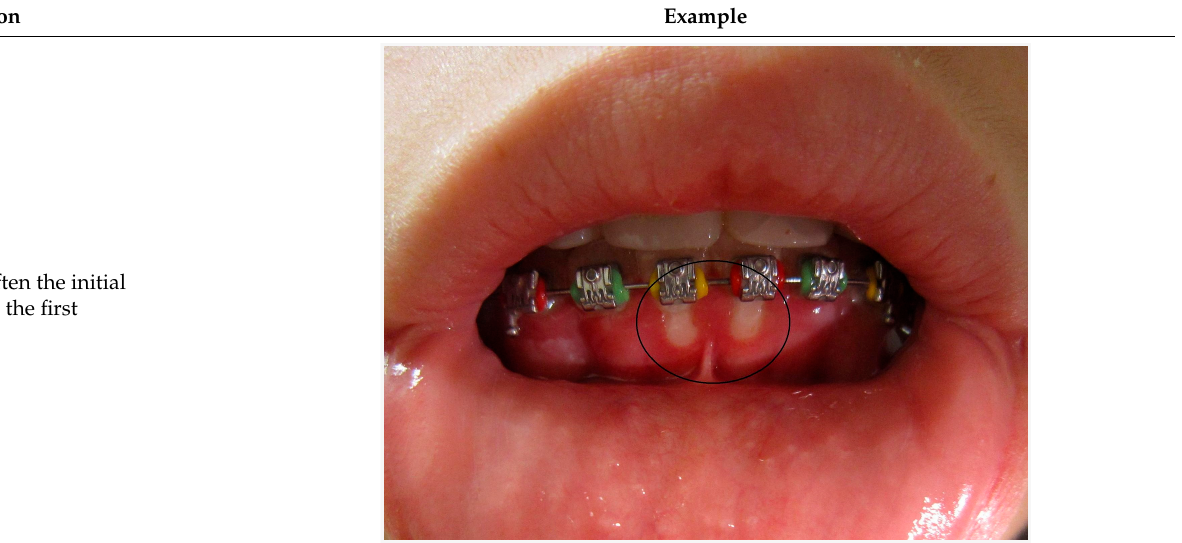
Table 1. Herpes oral and systemic manifestations.